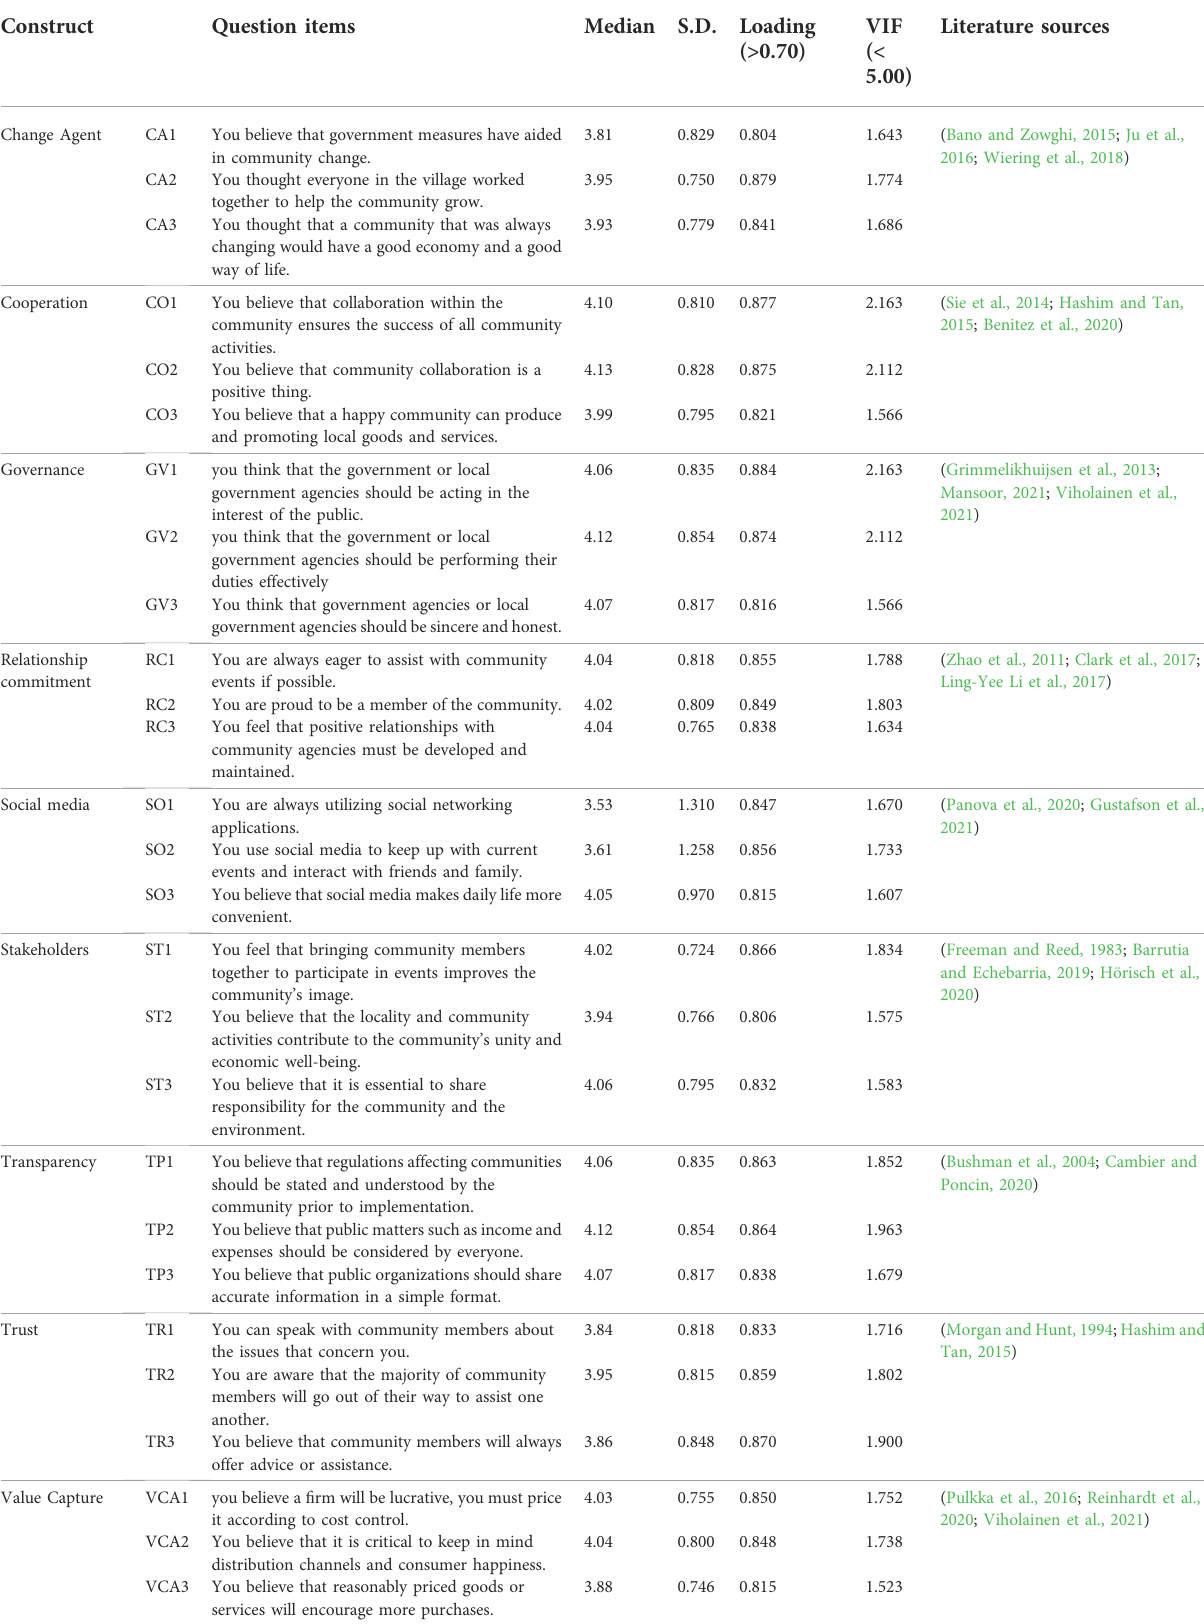
TABLE 5 The reliability and validity of the